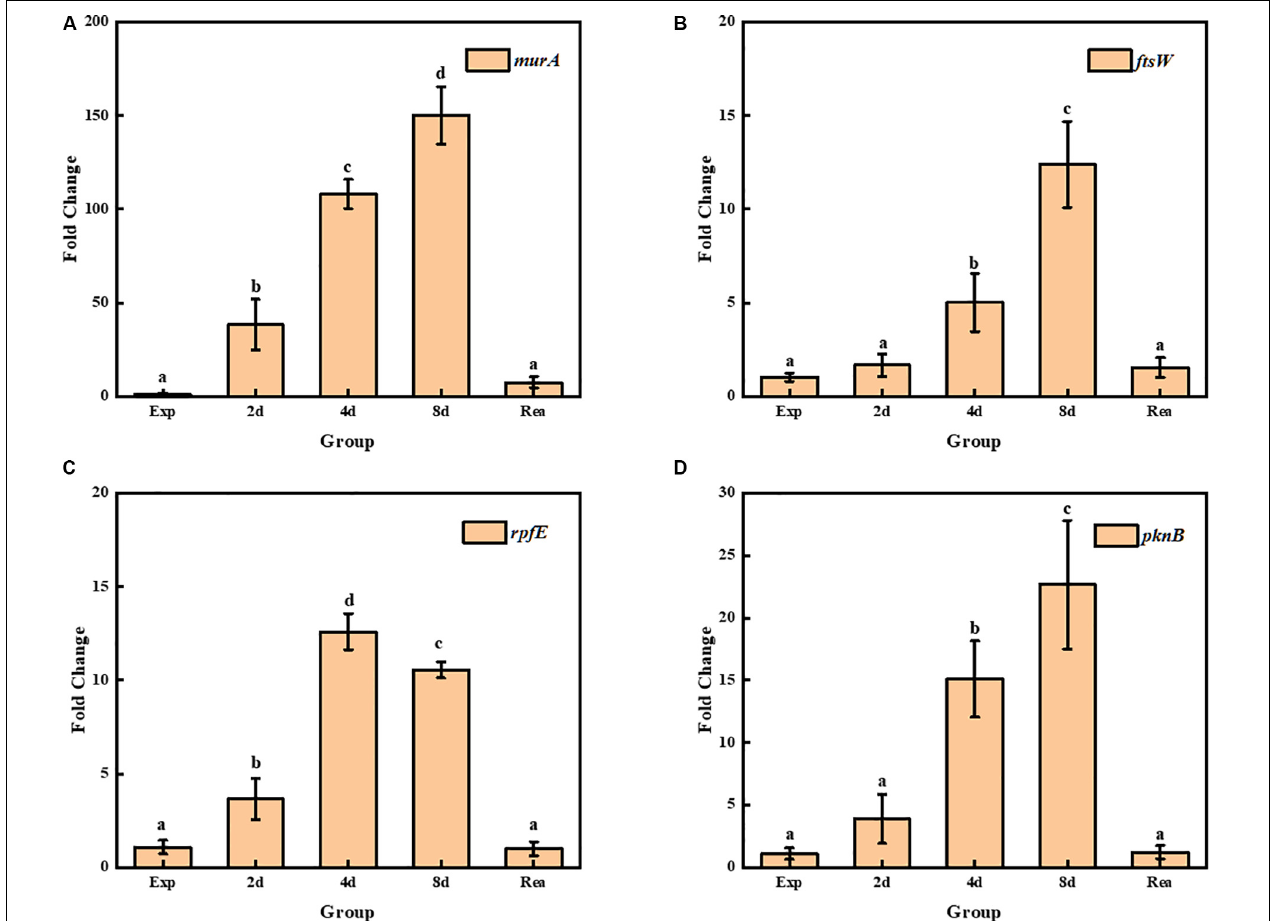
FIGURE 5 | Transcript levels of (A) murA , (B) ftsW , (C) rpfE , and (D) pknB in exponential phase cells, VBNC cells and resuscitated cells; Significant differences between means are indicated by different letters, p < 0.05. The data was normalized to the expression of the 16S rRNA gene, and the transcript level of each gene was compared to its transcript level in the normal TG9